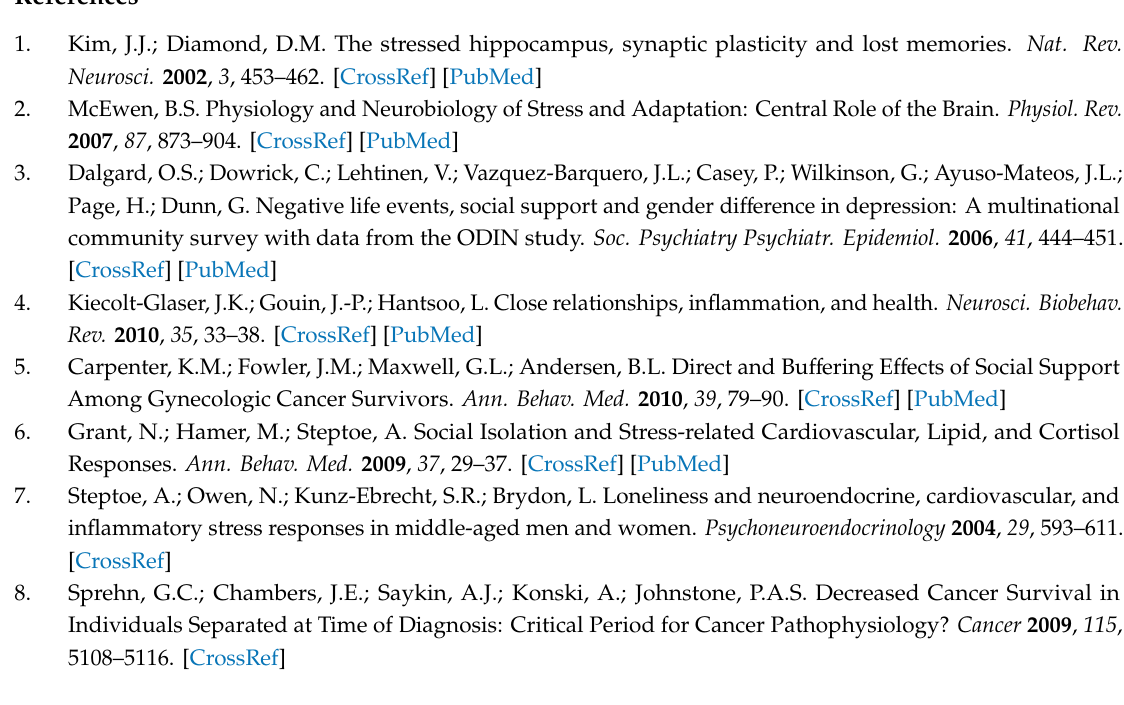
Table S1: The e ff ects of ethologically relevant stressors on the di ff erent stages of adult neurogenesis in several mammalian